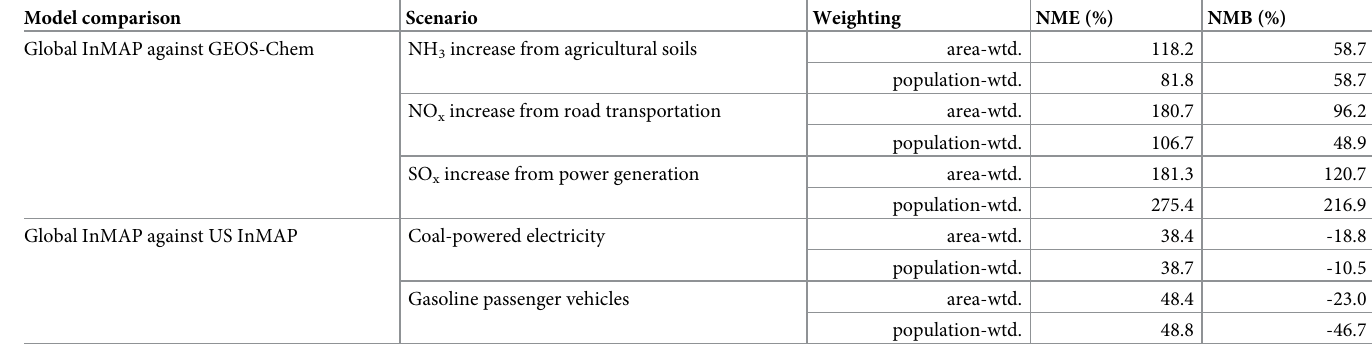
Table 2. Area- and population-weighted (wtd.) normalized mean bias (NMB) and error (NME) for Global InMAP predicted changes in concentrations against changes in concentrations from GEOS-Chem or US InMAP, arising from scenarios of changes in emissions. Positive bias indicates that Global InMAP has higher average concentration changes than the other model.